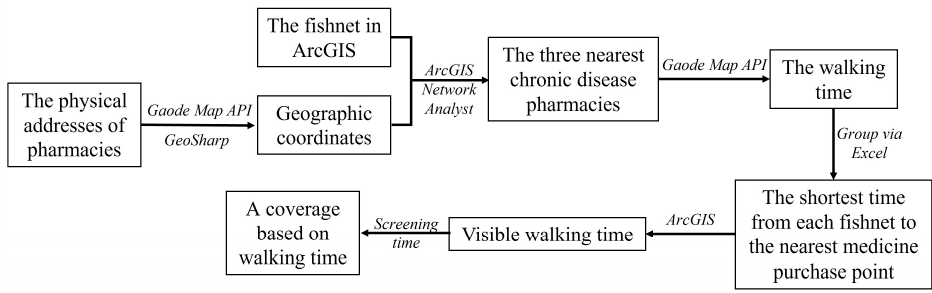
Figure 4. The workflow of measuring walking time by Web mapping.